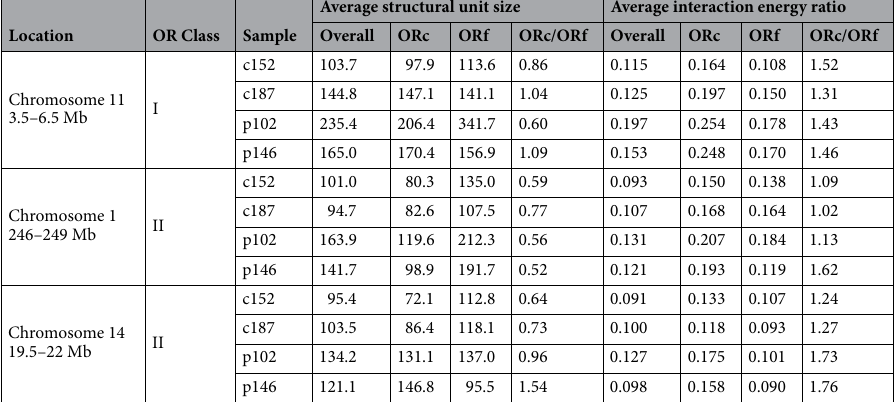
Table 1. Characteristics of structural units identified in neighborhoods of olfactory receptor gene clusters in chromosomes 1, 11, and 14. The average size of structural units and the average interaction energy ratio between structural units in selected regions containing OR clusters, featured in Figs. 4,5,6. The average size and interaction energy ratios for subgroups of OR-containing (ORc) and OR-free (ORf) structural units were also included, along with the ratio of averages for ORc to ORf